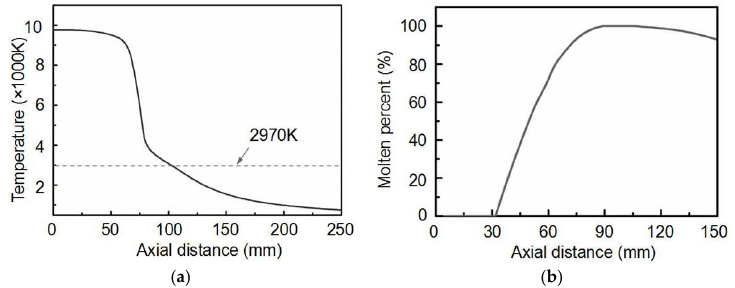
Figure 5. ( a ) Center temperatures of plasma flame and ( b ) molten percentage of YSZ agglomerated powder along axial distance in the plasma process.